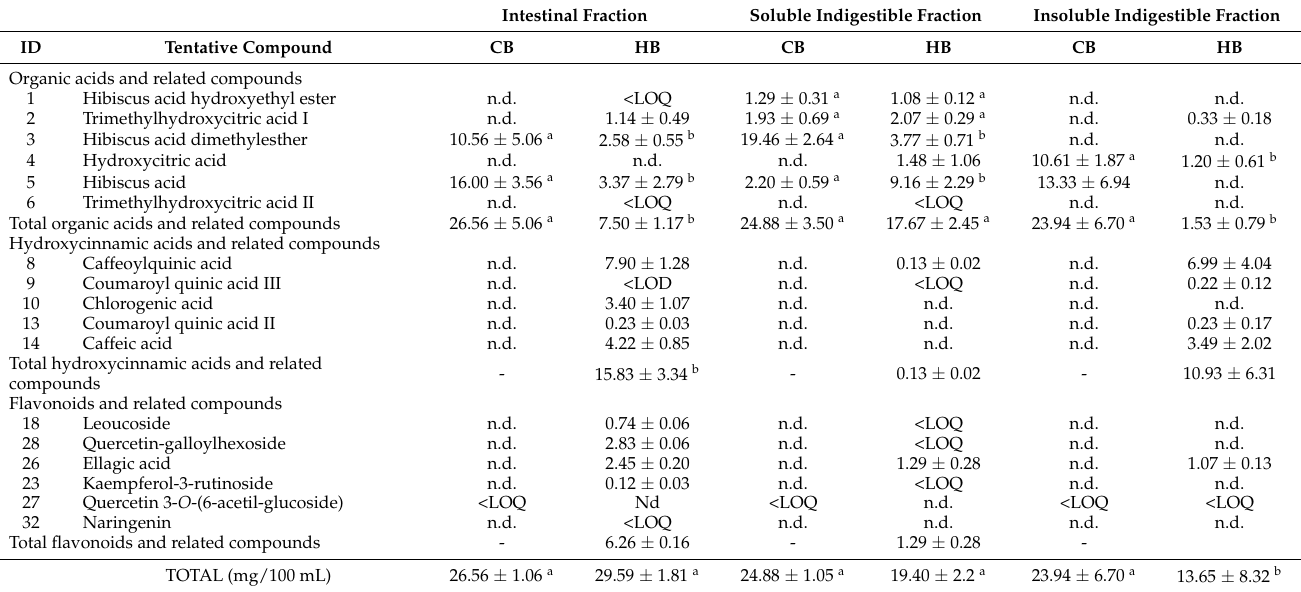
Table 3. Phenolic compounds and organic acids content after an in vitro gastrointestinal digestion of commercial (CB) and Hibiscus beverage (HB).